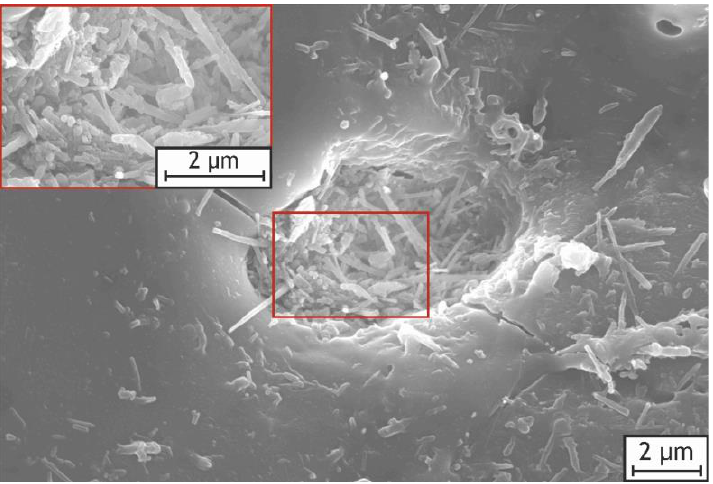
Figure 5. High-magnification SEM images of the H10 sample pore.